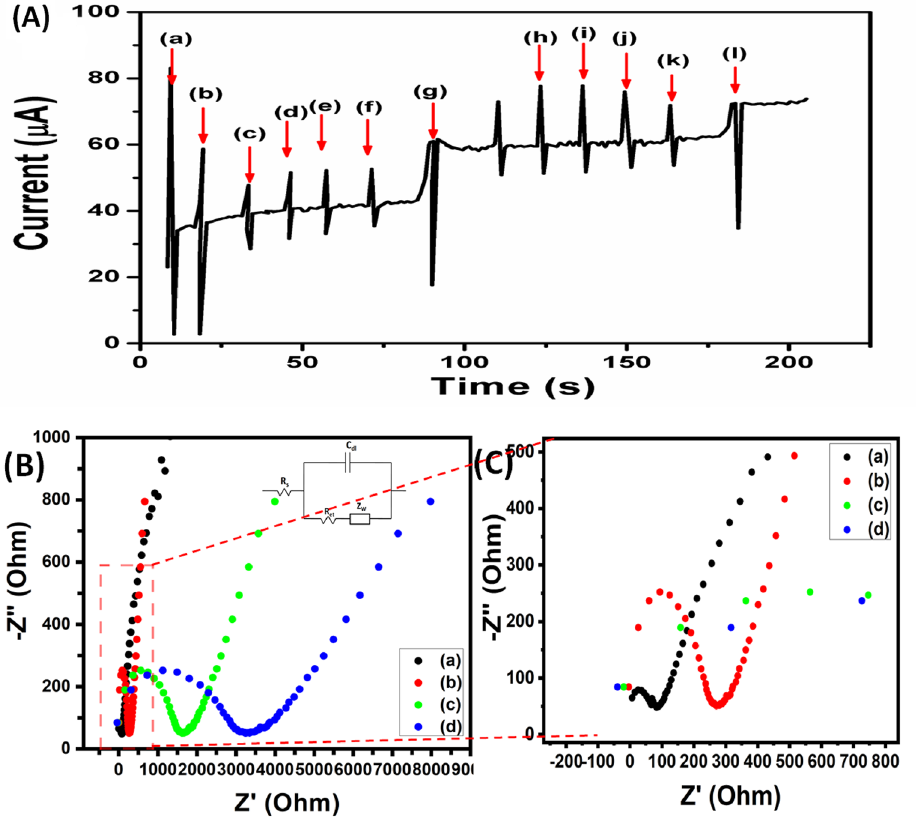
Figure 6. ( A ) Illustrates the amperometric result of the CuO/Ag/NiO -GCE electrode to the sequential addition of 0.1 mM glucose and 0.1 M NaOH solution of 0.01 Mm potential interfering species, including (a) glucose (b) AA, (c) DA, (d) UA, (e) Cys, (f) Ni 2+ , (g) Ca 2+ , (h) Mg 2+ , (i) lactose, (j) sucrose, (k) maltose, and (l) mannose at + 0.58 V (versus Ag/AgCl). ( B ) A representative Nyquist plot shows semicircle EIS spectrum in a solution of 5 mM [Fe(CN) 6 ] 3−/4− and 0.1 M KCl mixtures at an applied amplitude of ± 5 mV over a frequency range (0.01 Hz to100 MHz) of (a) CuO/Ag/NiO–GCE (b) CuO/Ag–GCE (c) CuO–GCE (d) b–GCE. ( C ) Clear zoom view of Nyquist plot shows clear semicircles EIS spectrum graph of (a) CuO/Ag/NiO–GCE and (b) CuO/Ag–GCE.